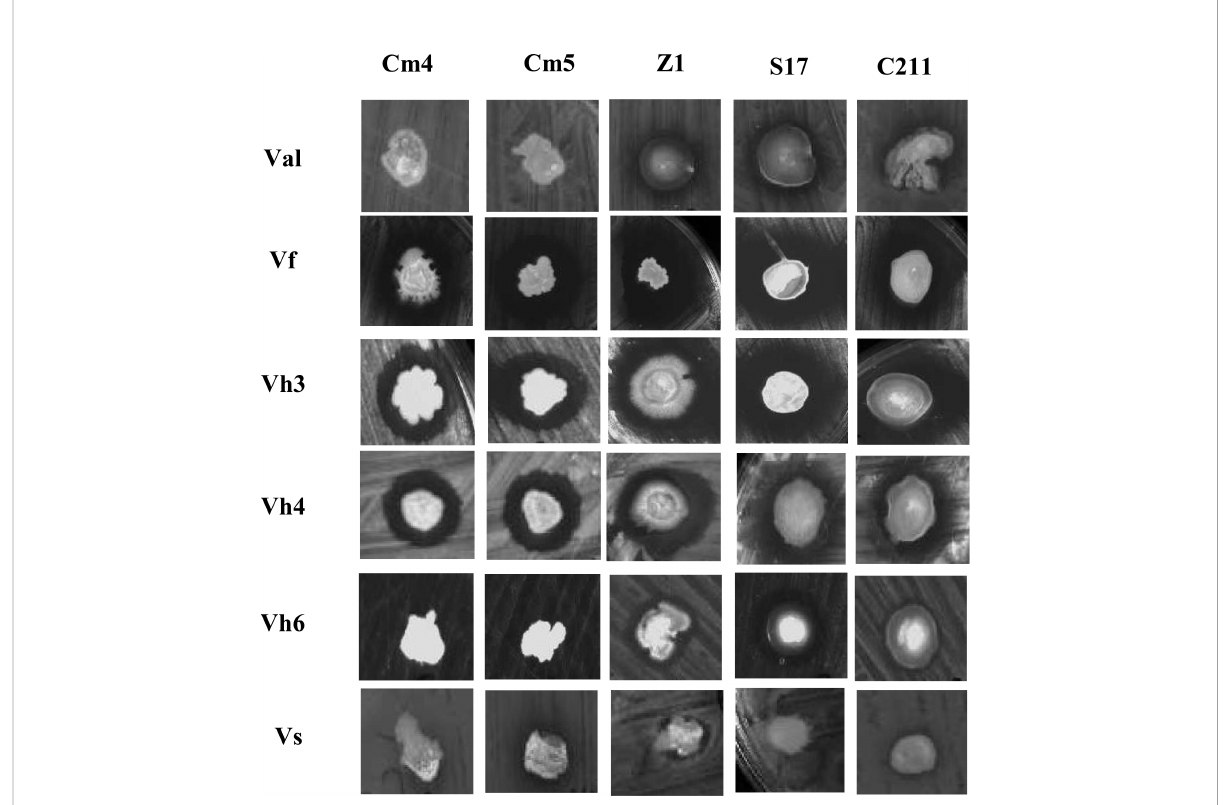
FIGURE 1 Pictorial overview of antimicrobial activities of selected strains against indicators Vibrios (colony overlay method).Val, V.alginolyticus; Vf, V. fi scherie; Vh3, V. harveyi Lg 26/01; Vh4, V. harveyi Lg 48/01; Vh6, V. harveyi Lg 34/04 and Vs, V. spendidus